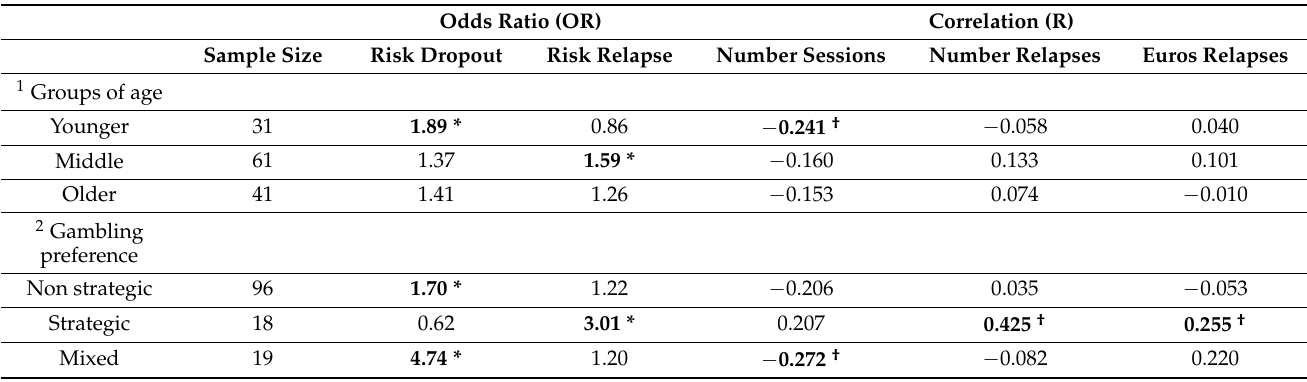
Table 2. Association of delay discounting with the CBT outcomes.